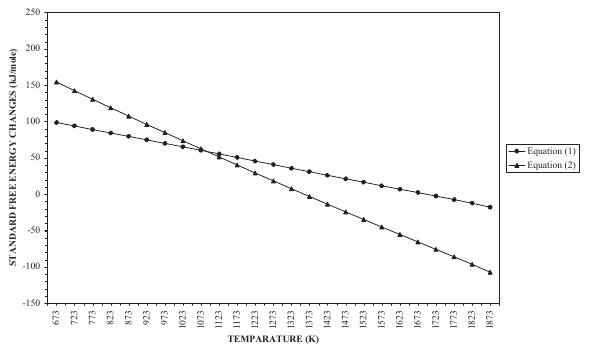
Figure 1. Standard free energy changes for the reduction of zinc ferrite by carbon monoxide and hydrogen in the temperature range of 673 to 1873 K (400 to 1600 ı C).